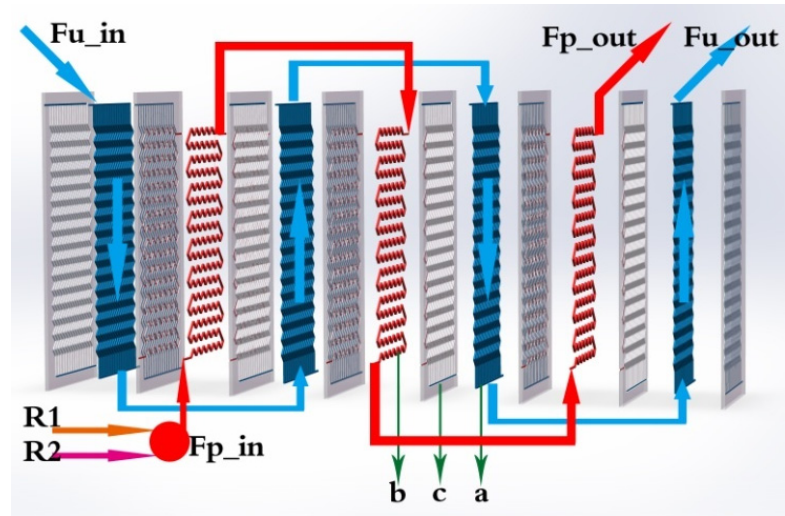
Figure 2. Block modeling description, showing ( a ) utility plate, ( b ) process plate, and ( c ) plate wall.